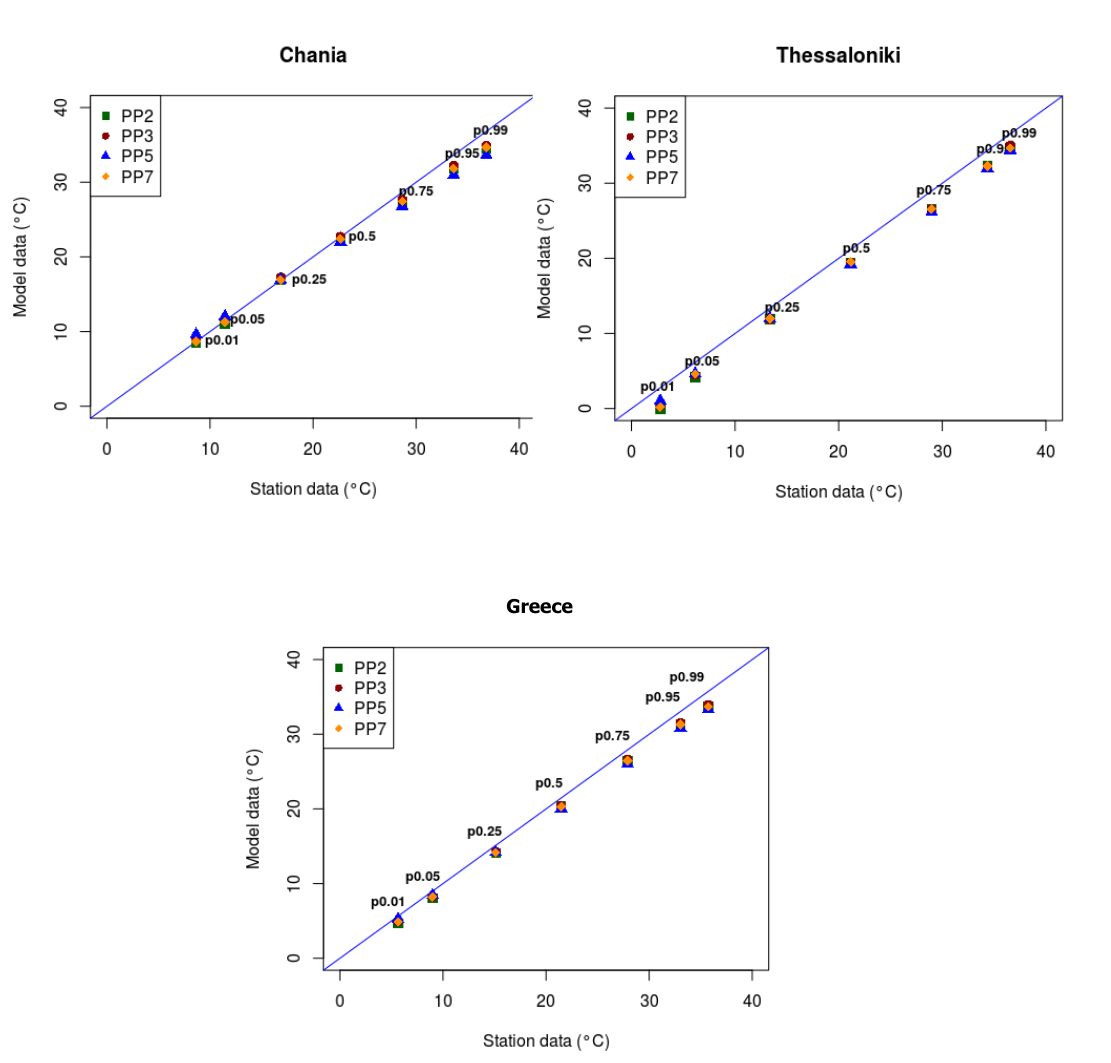
Figure 9. Percentiles of daily maximum temperature for the four WRF simulations vs. observational percentiles for some indicative stations and their average for the region of Greece (D02). Straight line represents the perfect performance.